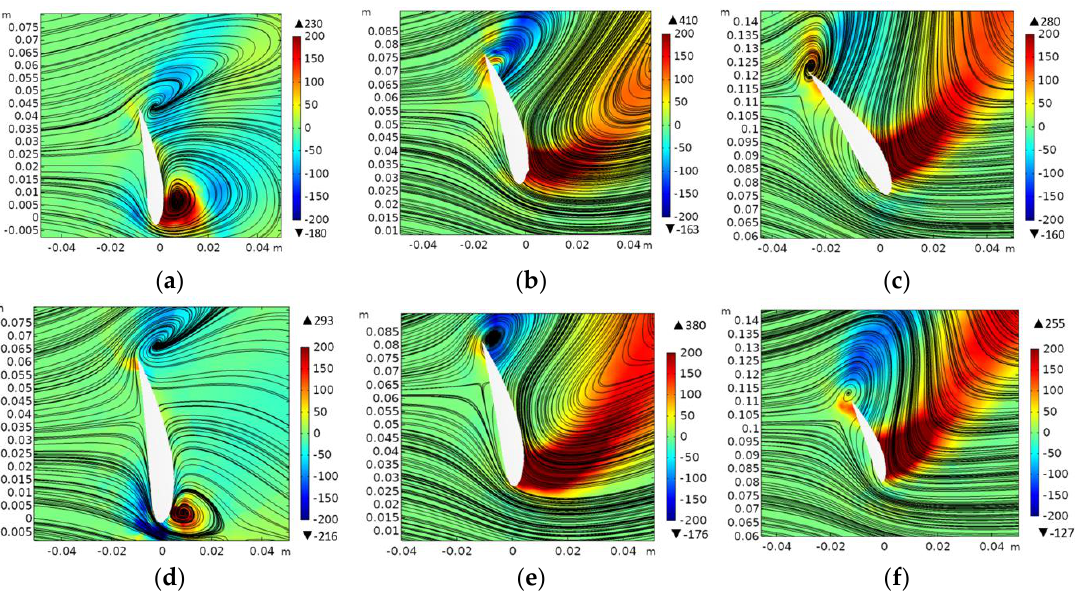
Figure 10. Blade cuts showing the vorticity contours and velocity streamlines of the flow across the blade ( a , d ) near the hub, ( b , e ) mid-span, and ( c , f ) near the tip for rectangular ( a – c ) and tapered ( d – f ) configurations.